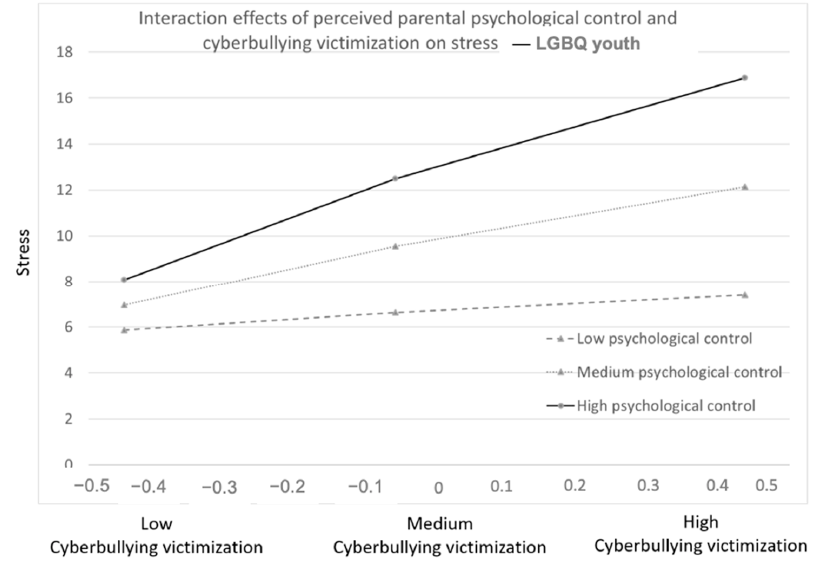
Figure 2. Interaction between cyberbullying victimization, perceived parental psychological con- trol, and stress, among LGBQ youth. Bold: It is to point out that these findings were only found for LGBQ youth.